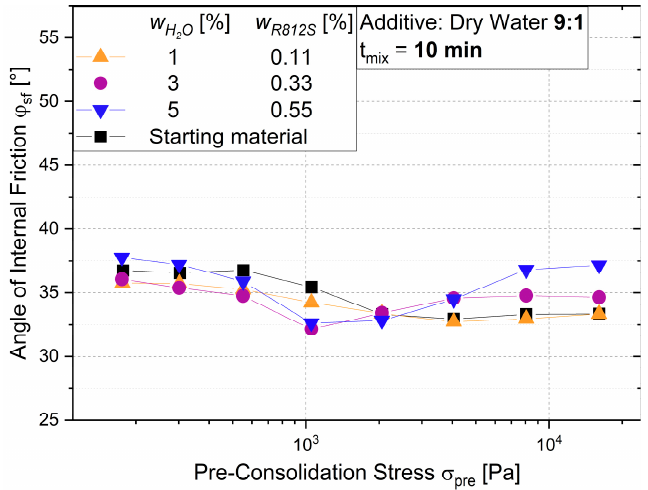
Figure 17. Angle of internal friction at steady-state flow φ sf in dependence of the pre-consolidation stress for coarse sand and mixtures of coarse sand and dry water (ratio 9:1) at: w H2O = 1%, w H2O = 3% and w H2O = 5%.